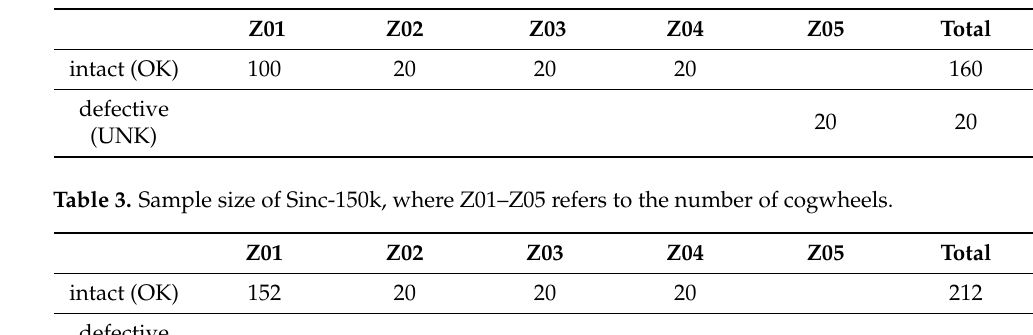
Table 2. Sample size of Crp1k-200k and RC2-75k, where Z01–Z05 refers to the number of cogwheels.